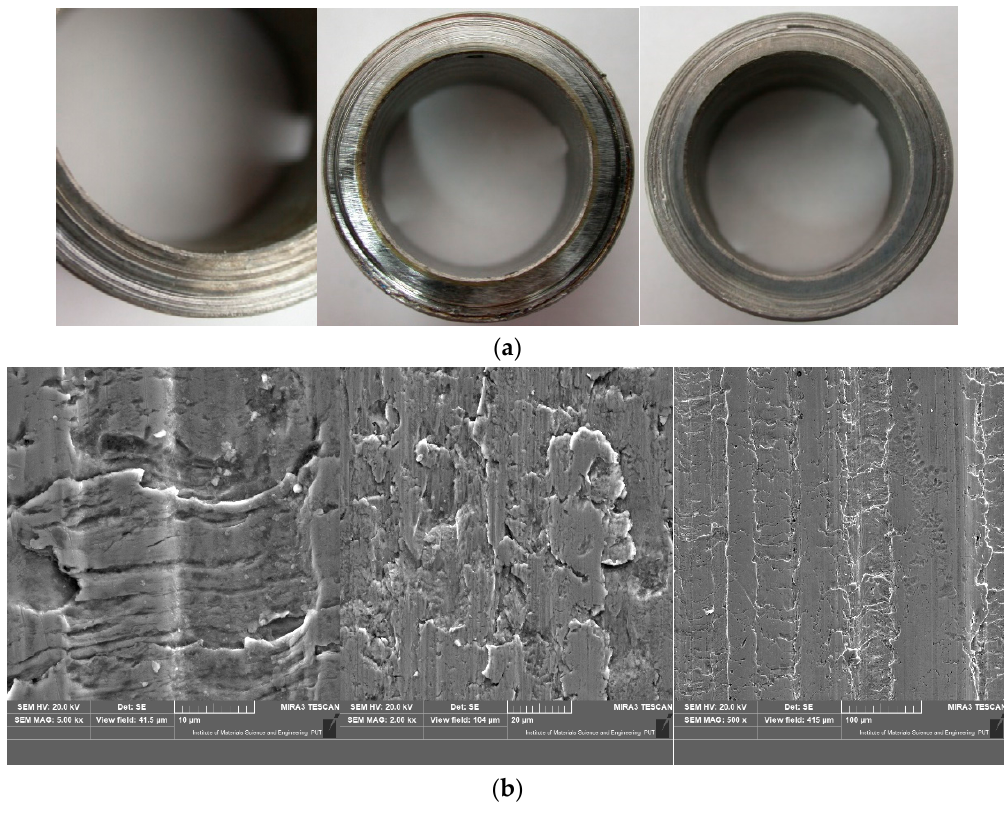
Figure 19. View of the wear surface of the samples for experiment VI; ( a ) view of the sample after test and ( b ) SEM images of the surface.